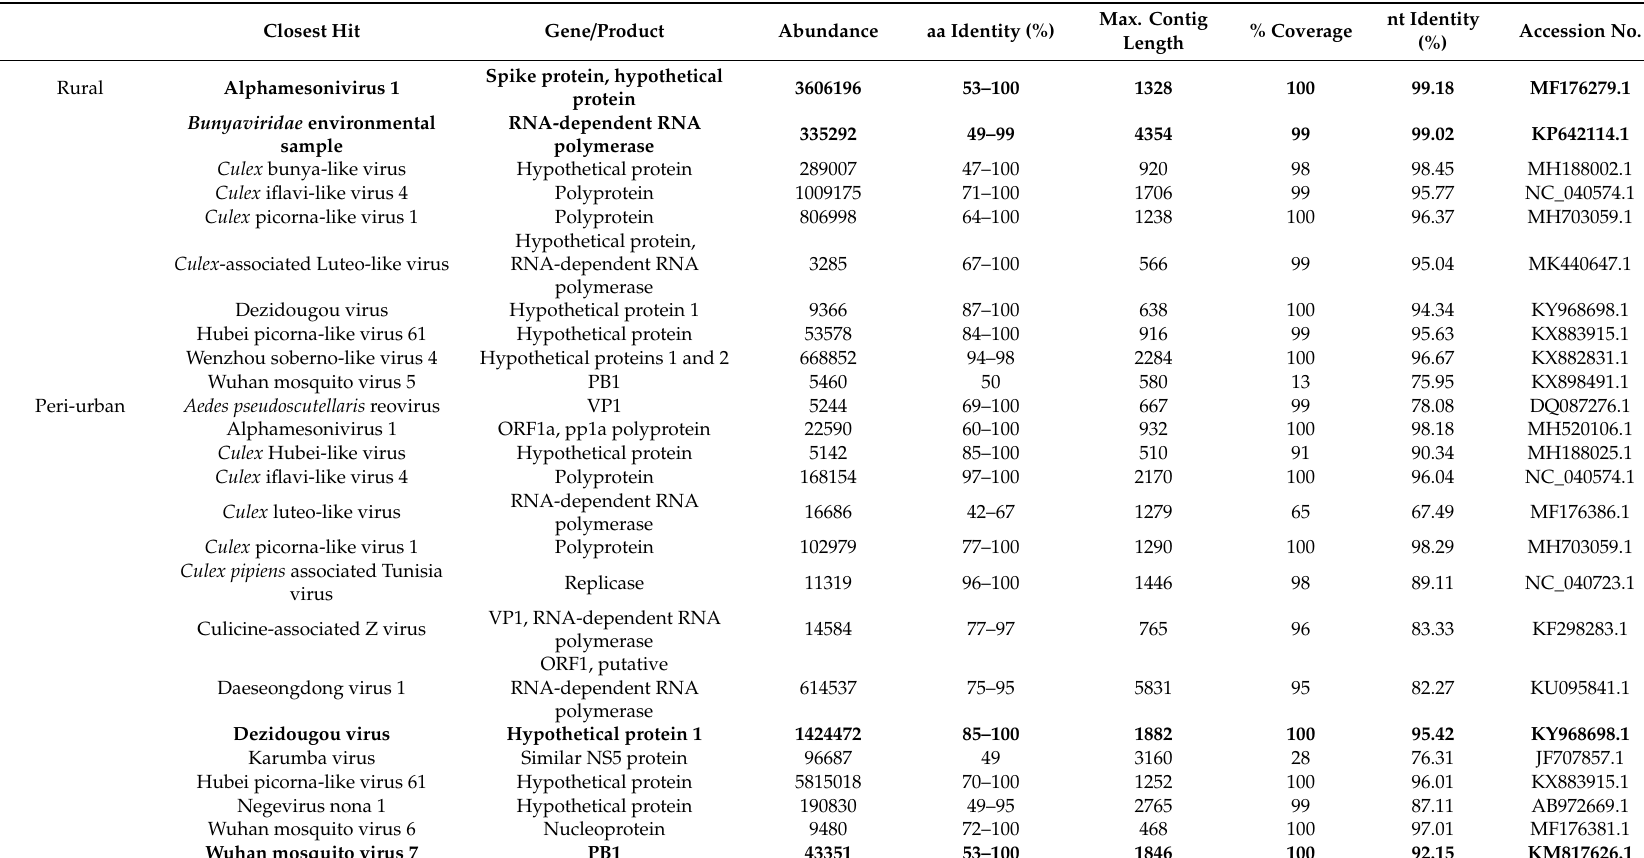
Table 2. Mosquito-associated viruses identified in honey-baited Flinders’ Technology Associates (FTA) cards by next-generation sequencing (NGS) analysis. Taxonomic assignations with assembly lengths higher than 400 nt are shown. Abundance and contig length are expressed in nucleotides (nt). Viral identities are expressed in nucleotides and amino acids